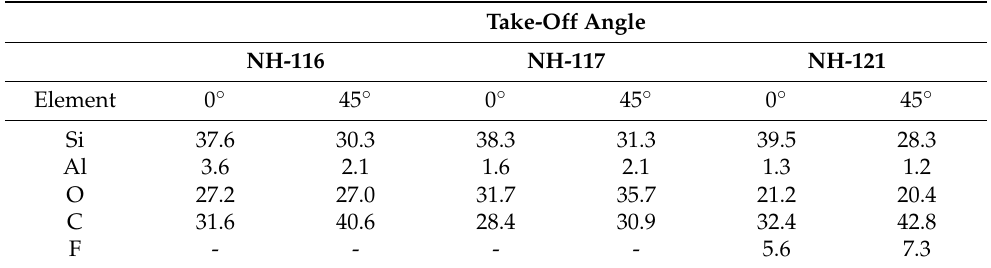
Table 1. Elemental composition (at.%) of the air-exposed samples based on the XPS experiments. Take-Off Angle NH-116 NH-117 NH-121 Element